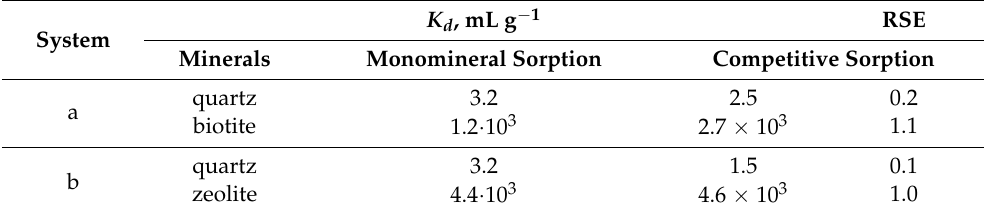
Table 3. Cesium distribution coefficients on mineral phases in the cases of monomineral sorption and competitive sorption between quartz and biotite, quartz and zeolite NaA. RSE parameters determined in the case of competitive sorption of the same